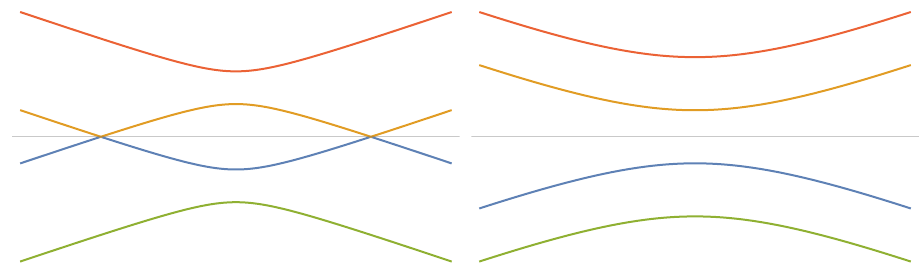
p b 2 (cid:0) M 2 which indicates the